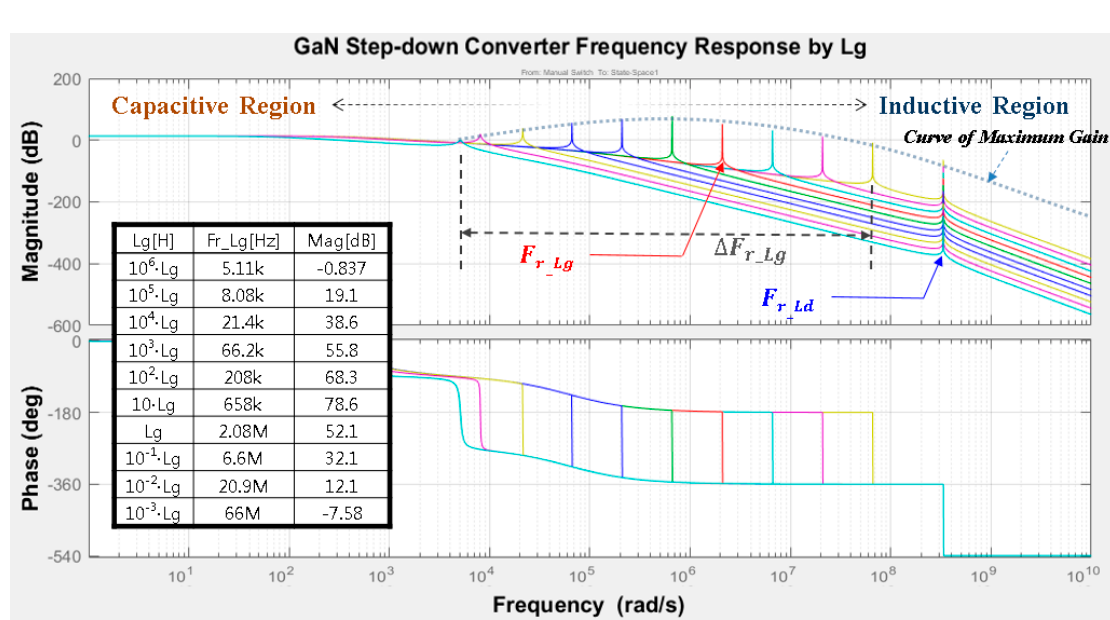
Figure 7. The system frequency response with variation of gate-inductance ( L g ).